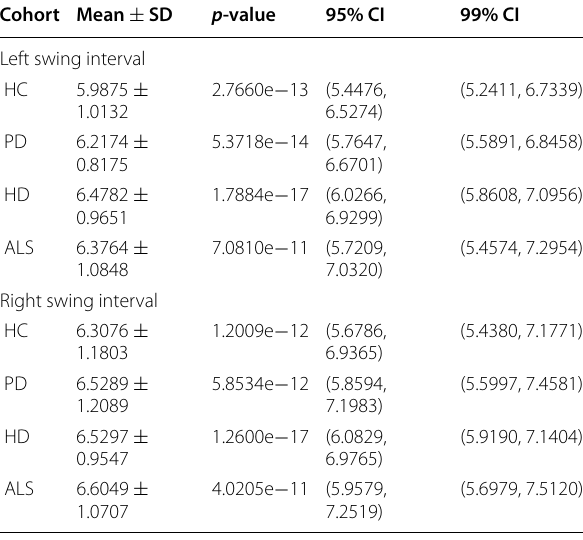
Table 5 Average largest eigenvalues and confidence intervals of left and right swing intervals